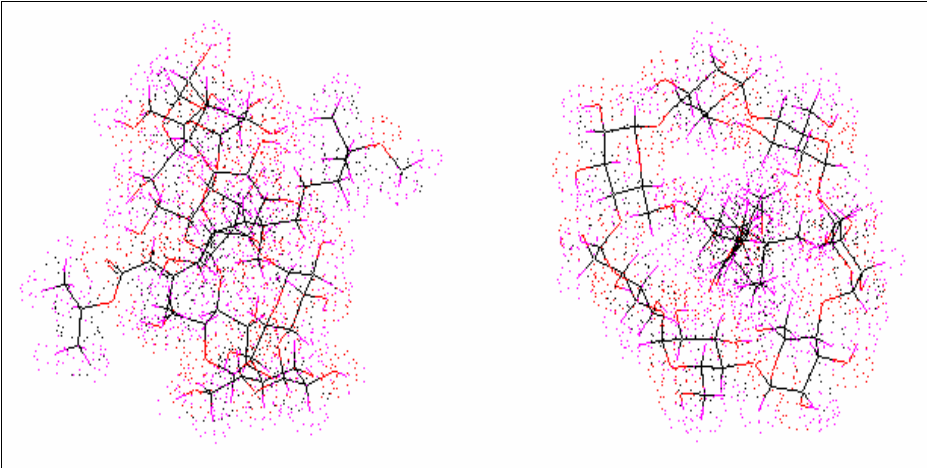
Figure 3. Snapshot of the equilibrium configuration for the BCD-methoprene